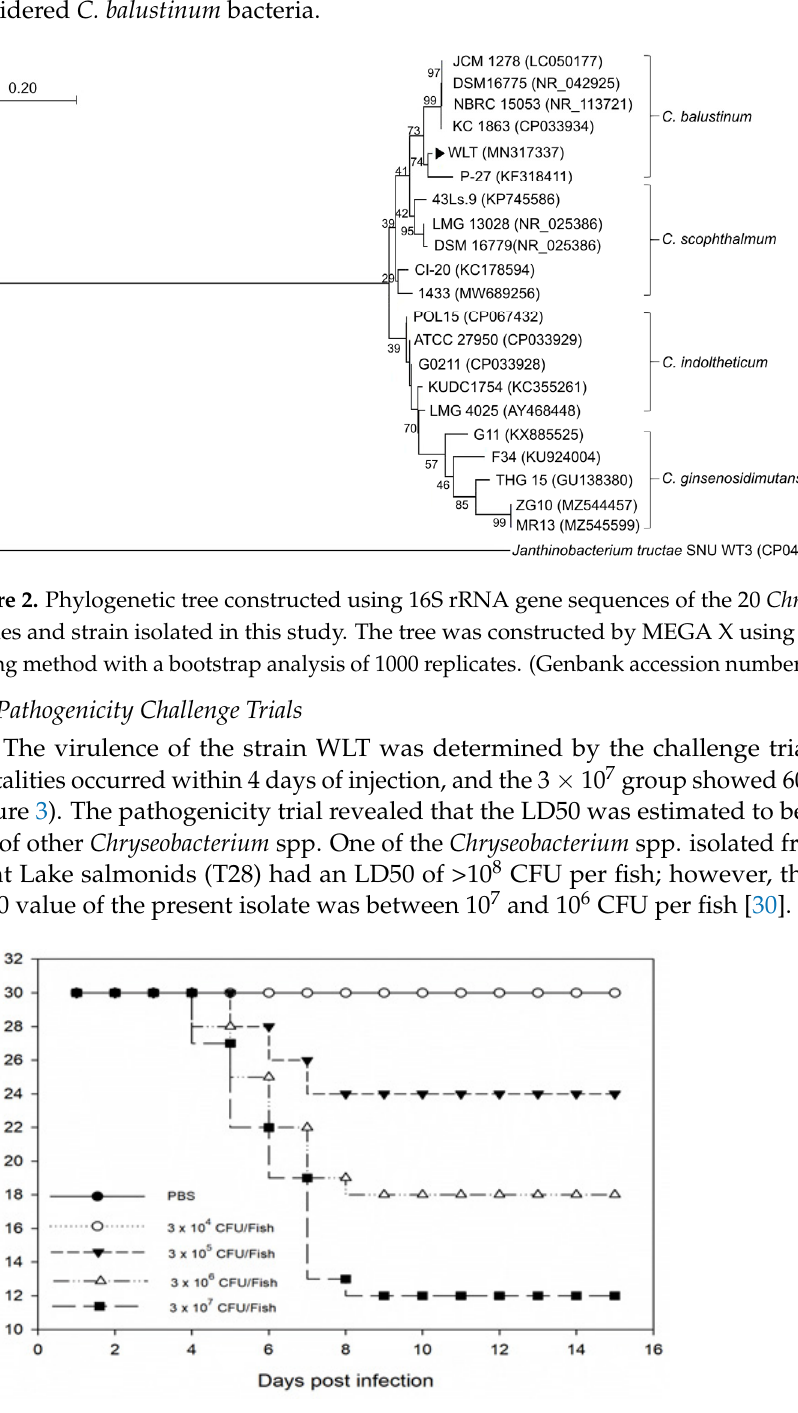
Figure 4. Histopathology of liver of healthy rainbow trout ( A ) and a moribund rainbow trout with Chryseobacterium balustinum WLT infection ( B ). Necrosis and cytoplasmic vacuolation can be observed in hepatic cells on liver of diseased fish. Slides were stained with hematoxylin and eosin. Scale bars = 20 μ m. Table 1. Antibiotic susceptibility test performed on C. balustinum WLT by disk diffusion method (R: resistant, S: susceptible, I: intermediate). Antibiotics